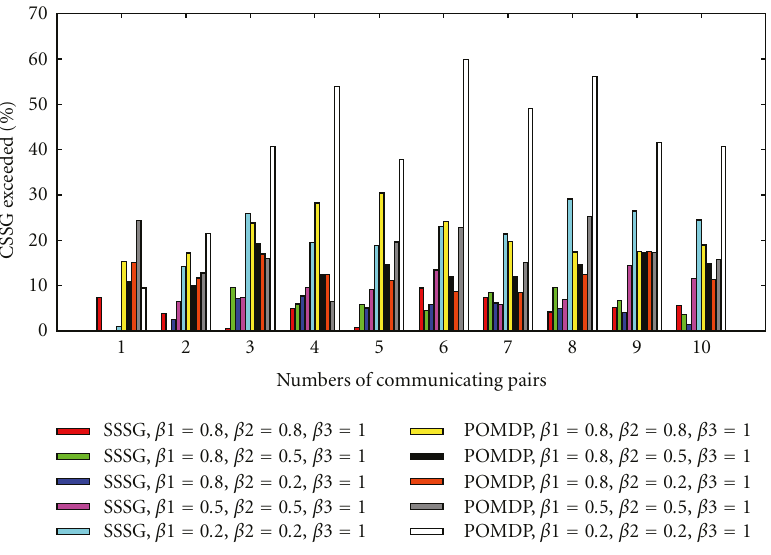
Figure 19: Various cases compared to CSSG with 2 channels have PUs’